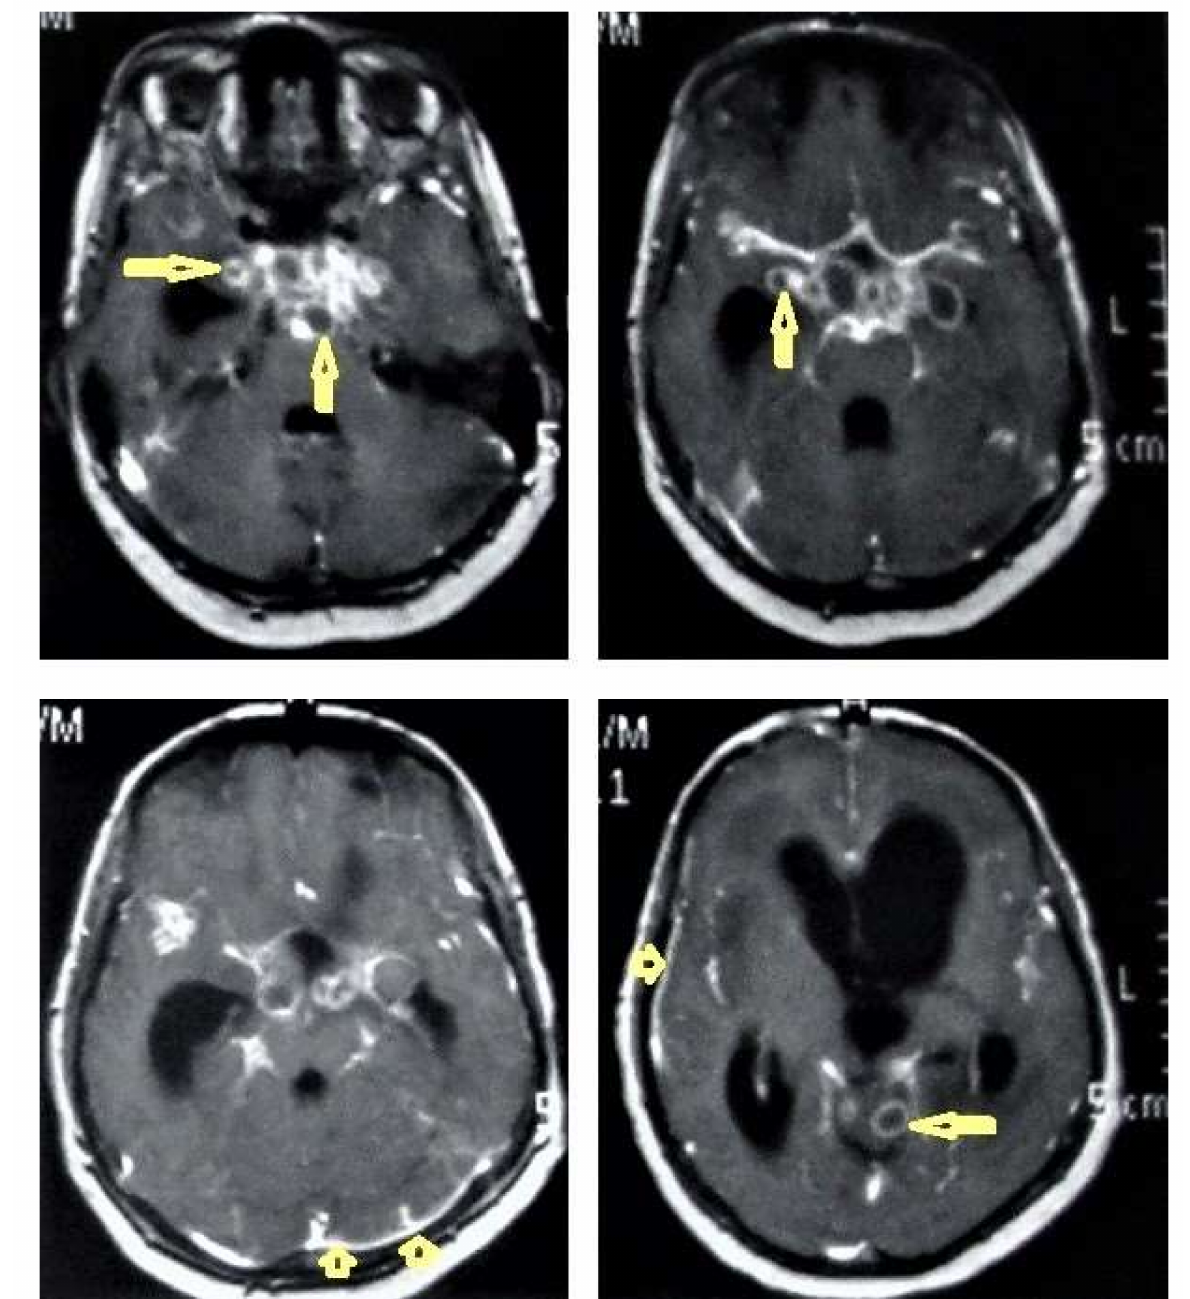
Figure 12. Tuberculous leptomeningitis. Selected axial T1-weighted images of brain MRI post- contrast administration show diffuse leptomeningeal enhancement (short arrows) with predilection to involve the basal cisterns complicated with hydrocephalus. Multiple ring-enhancing lesions (long arrows) in different regions of the